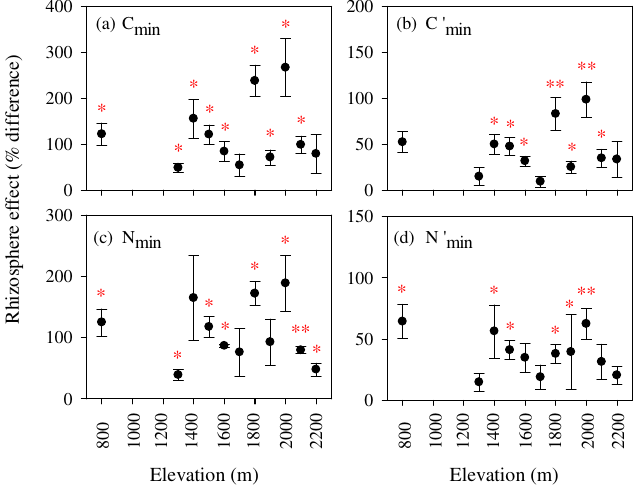
Figure 2. Relationship of the rhizosphere effects on soil carbon mineralization rate per soil mass (C min , ( a )), carbon mineralization rate per soil total carbon (C’ min , ( b )), nitrogen mineralization rate per soil mass (N min , ( c )), nitrogen mineralization rate per soil total nitrogen (N’ min , ( d )) with eleva- tion. There was no significant linear regression ( p > 0.05). For each elevation, values are the means and error bars are the standard errors of replicated plots ( n = 4). Asterisks indicate significant dif- ferences between rhizosphere soil and bulk soil based on paired−samples t −tests (* p < 0.05 and ** p < 0.01). The REs on soil microbial biomass carbon (MBC) and two extracellular enzyme ac- tivities (BG and NAG) were significantly positive across altitudes (Figure 1). The REs on MBC, BG, and NAG, on average, were 74%, 36%, and 49%, respectively (Figure 1). Alt- hough the RE on oxidase (OX) was not significant across altitudes (Figure 1), two out of eleven altitudes of the RE on OX were significantly negative (Figure 3d). We did not found the significant linear regression relationships between REs and altitude (Figure 3). The REs on soil TC, TN, NH ＋ 4 —N, NO － 3 —N, P, K, Ca, Mg, Fe, and Mn were signifi- cantly positive across altitudes (Figure 1). The mean magnitudes of the REs on TC and TN were 59% and 49%, respectively. Moreover, the concentration of inorganic nitrogen and extractable P were higher in the rhizosphere soil than in the bulk soil (Figure 4). The mean magnitudes of REs on soil metal cations (K, Ca, Mg, Fe, and Mn) are generally varied within the range of 29%~56% (Figure 5). In contrast to the above soil properties, the RE on soil pH was significantly negative despite the small (−1.6%) intensity (Figure 1). Notably, the RE on extractable Na was not significant across altitudes, but significant positive ef- fects were identified in three out of eleven altitudes (Figures 1 and 5). The linear regression relationships between REs on soil properties and altitude were not significant (Figures 4 and 5).